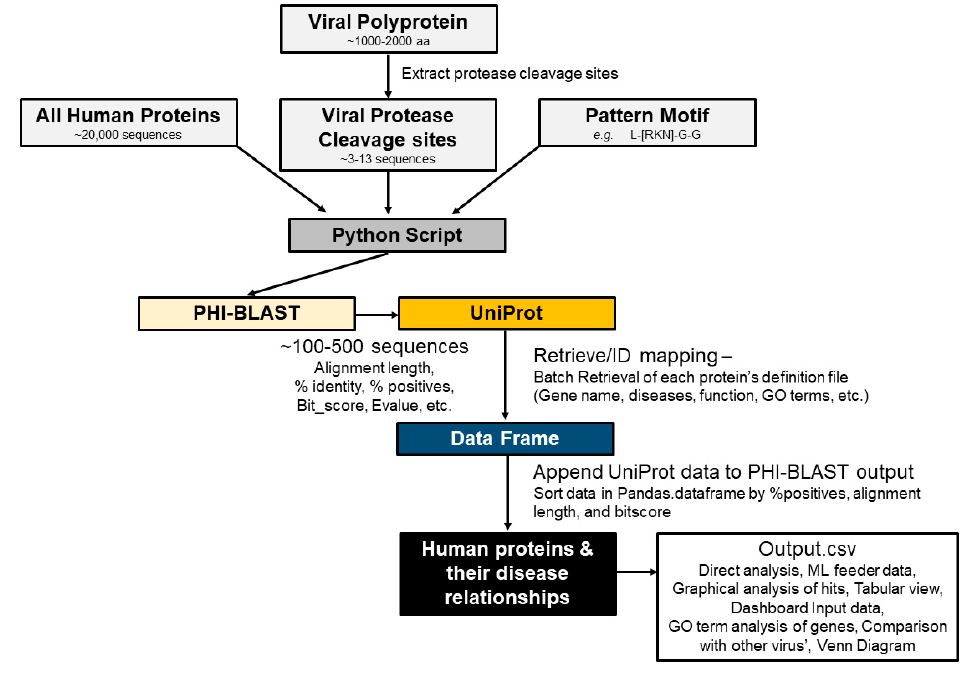
Figure 2. Automation of the SSHHPS analysis.